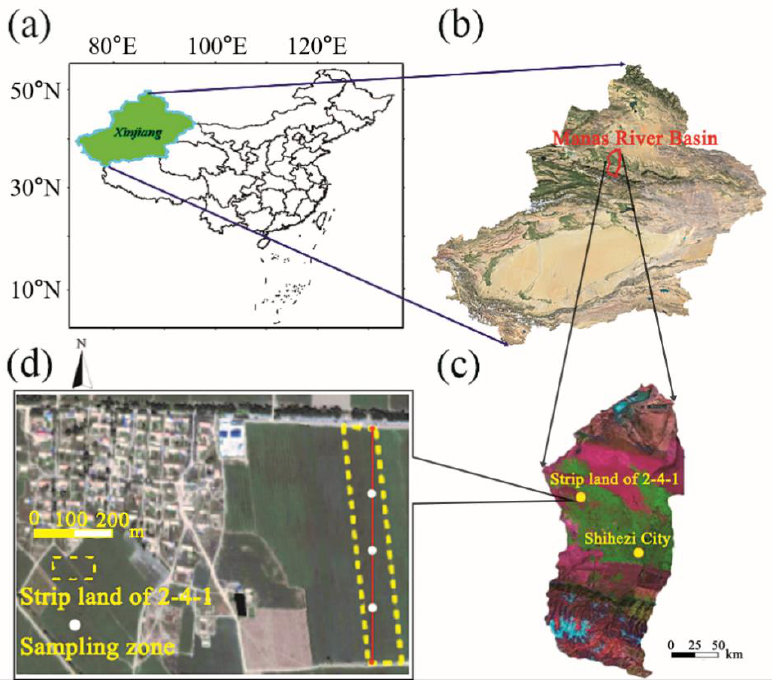
Figure 1. Xinjiang is located at the northwest of China ( a ); Xinjiang is characterized by extremely arid desert climate ( b ); Sampling location is in the typical oasis area near the city of Shihezi, Xinjiang ( c ); Three sampling zones are located at ¼ , ½ , and ¾ of the distance along the diagonal line running from the northeast corner of the field to the southwest corner ( d ).